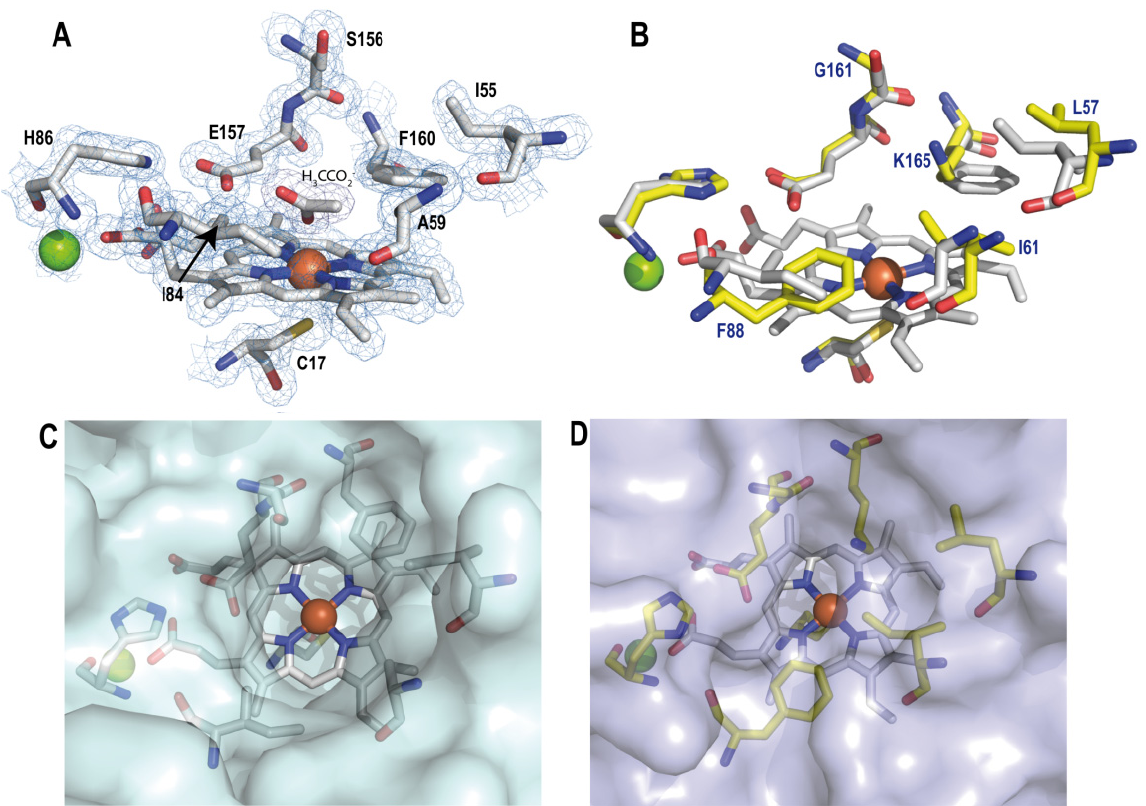
Figure 2. Heme pocket residues (top) and access channels (bottom). ( A ) View of the heme cavity in r Mro UPO with Ile84, His86, Glu157, and Phe160 at the upper side and the characteristic proximal Cys17 at the lower side (neighbor I55, A59, and S156 residues and acetate ion are also shown). The 1.4 Å resolution 2Fo-Fc electron density map (blue) contoured at 1.0 σ is included. ( B ) Active site differences between r Mro UPO (gray) and r Cvi UPO (yellow). Only noncommon residues in r Cvi UPO, including Leu57, Ile61, Phe88, Gly161, and Lys165, are labeled. ( C , D ) Semitransparent surfaces show the access channel to the heme in r Mro UPO and r Cvi UPO, respectively. The equivalent positions of Ala59, Ile84, and Phe160 in r Mro UPO change to Ile61, Phe88, and Lys165 in r Cvi UPO, reducing the entrance to the channel. These residues and acetate ion are shown as CPK sticks, while the Fe 3+ and Mg 2+ ions are shown as red and green spheres, respectively.